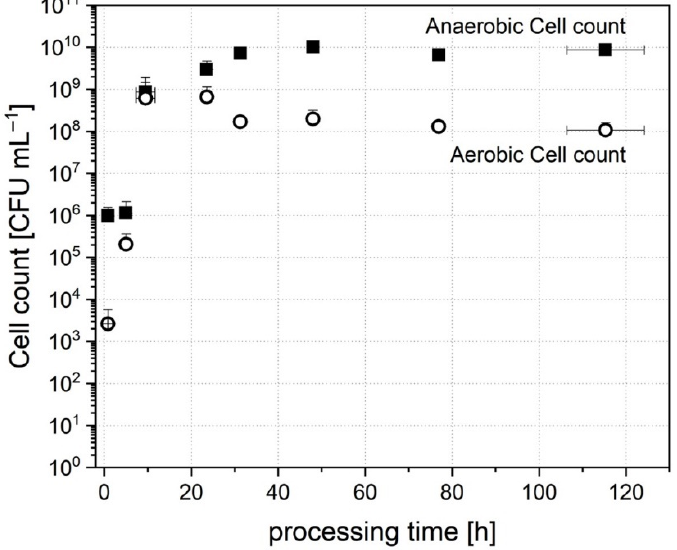
Figure 2. Cell count of anaerobic and aerobic cell count over processing time during cultivation of donor stool A.